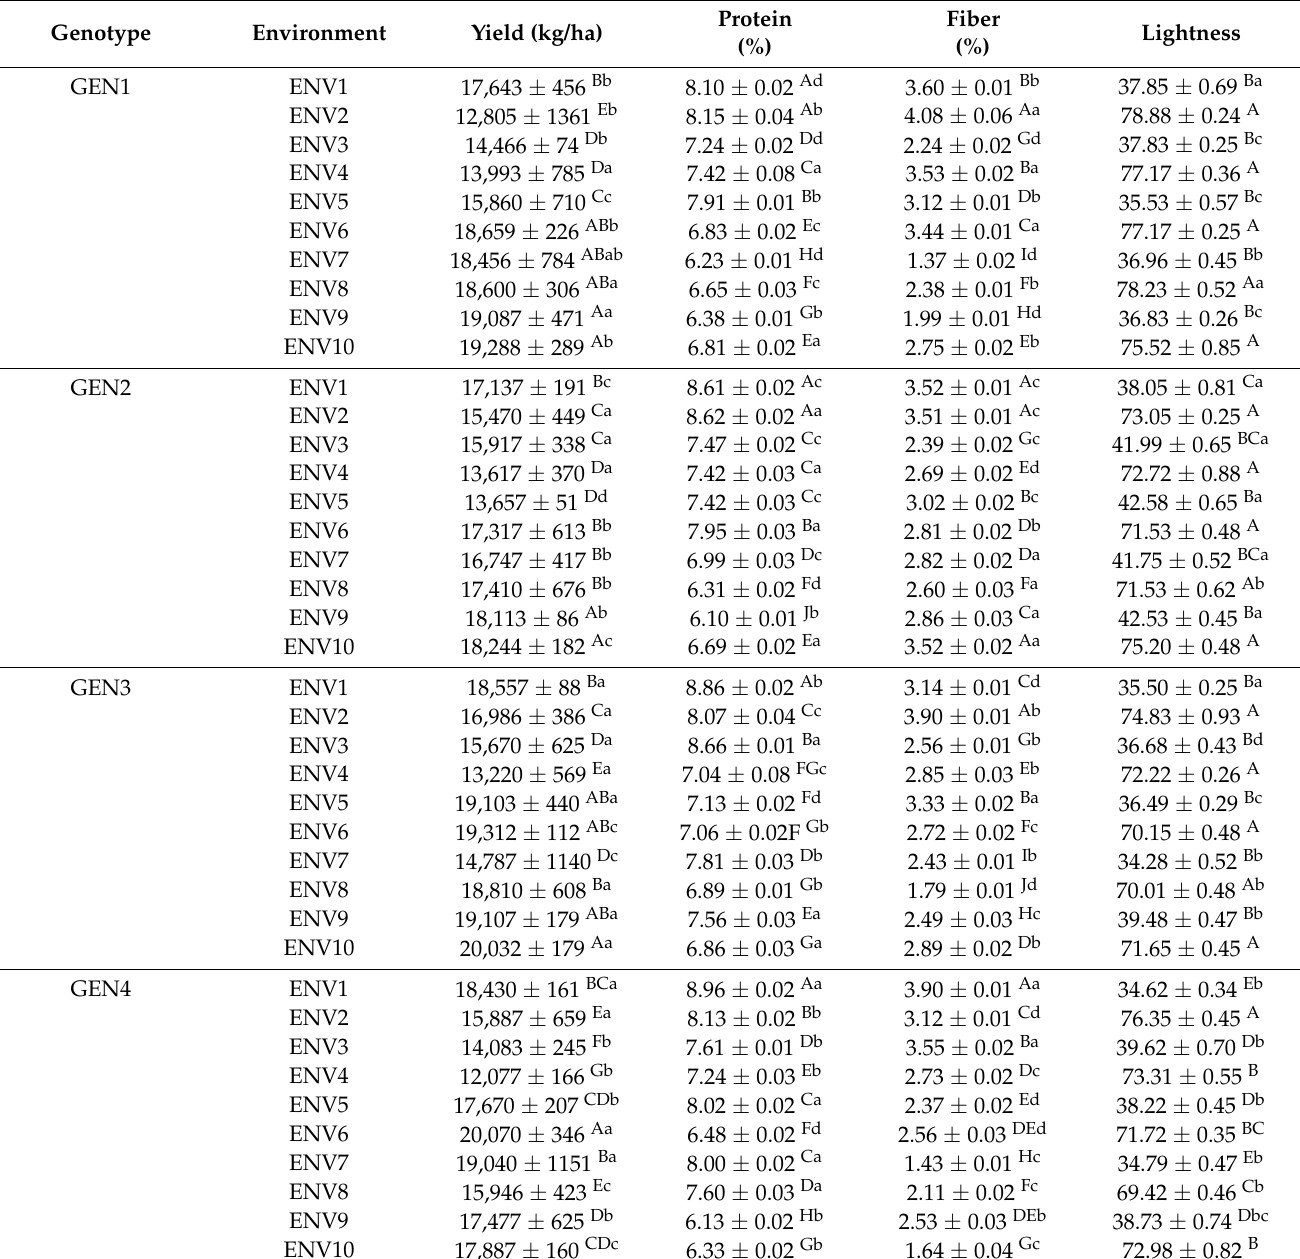
results when GEN3 was used except ENV6 and ENV7, which had their lowest performance with this genotype. Table 1. Effect of genotype and environments on yield and quality characteristics (protein, fiber, color parameters, texture and ash content) of corn